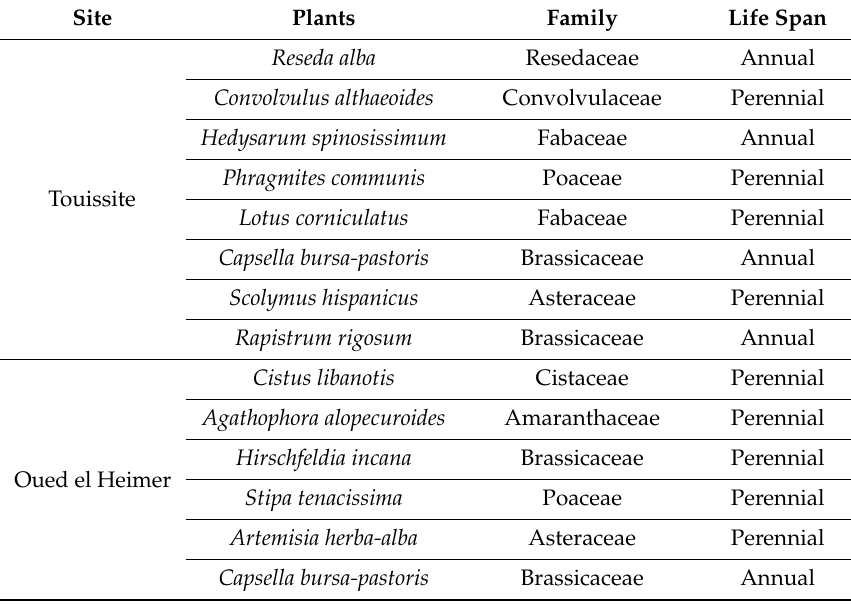
Table 2. List of sampled plants in the vicinity of the studied sites. Site Plants Family Life Span Reseda